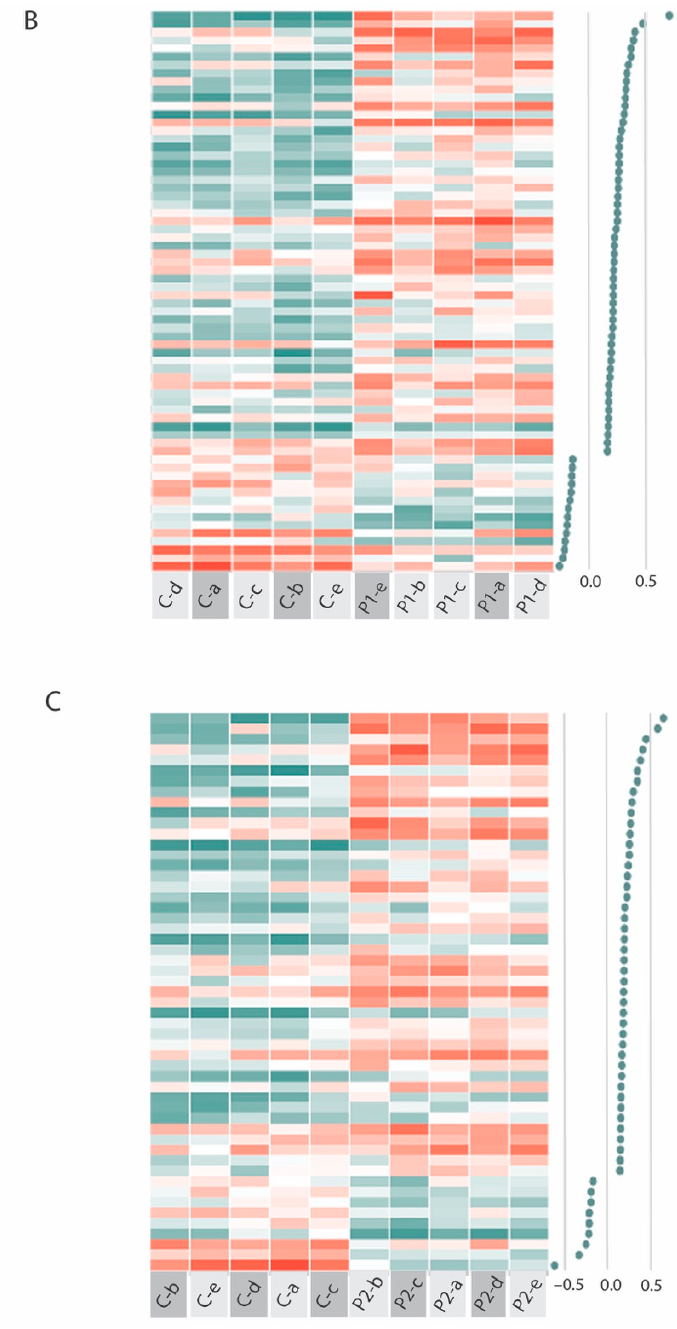
Figure 3. Heatmap showing the individual methylation variation at ME-iVMFs of interest. ( A ) Shows the methylation percent variation across all 577 statistically significant ME-iVMFs detected across all 15 samples. ( B ) shows the methylation variation in 68 ME-iVMFs where the mean methylation difference between the P1 and C groups is greater than 15% and ( C ) shows the methylation variation in 53 ME-iVMFs where the mean methylation difference between the P2 and C groups is greater than 15%. The dot plots associated with B and C on the right of the figure show the degree of differential methylation. The scale below Figure 3A shows the corresponding colour associated with the methylation